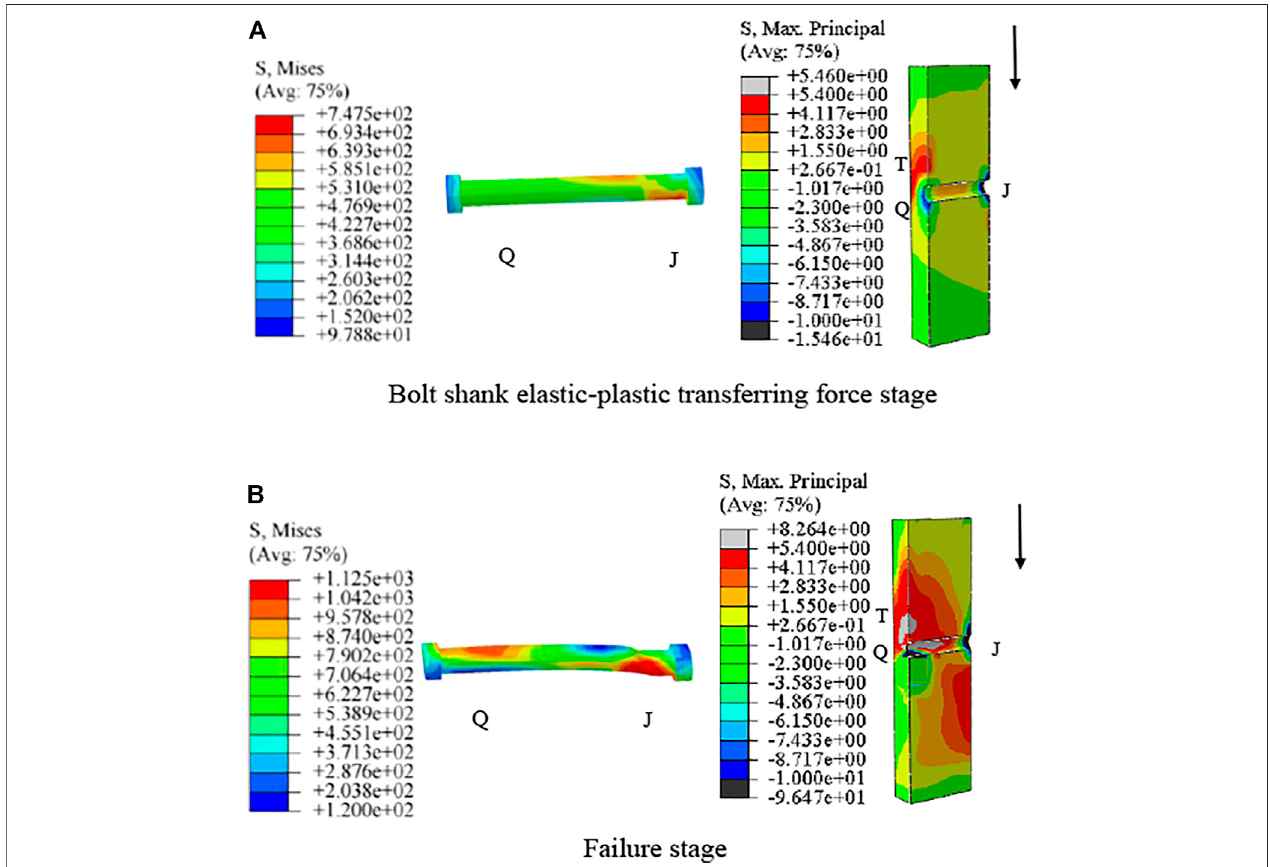
FIGURE 12 | Stress distribution in HSFGBs and concrete slabs in SFRC-24- α 1-10.9 specimen (MPa).